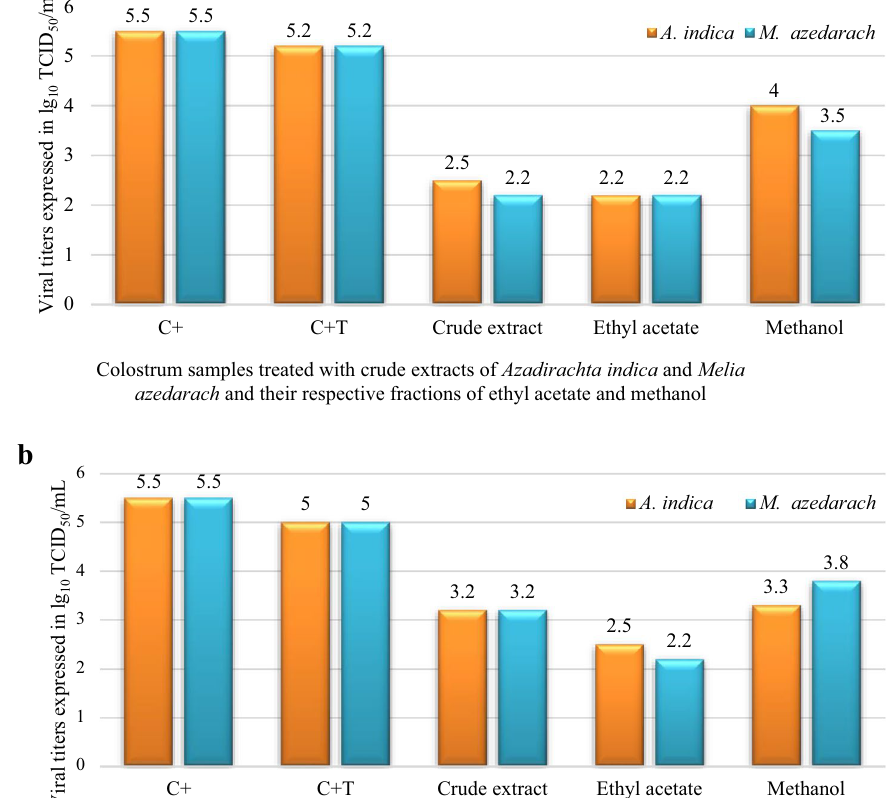
Figure 5. Viral titers of milk and colostrum samples co-cultured with ovine third eyelid (OTE) cells submitted to 90 min treatment composed of ethanolic leaf extracts of Azadirachta indica and Melia azedarach . ( a ) Colostrum samples treated with crude extract of A. indica and M. azedarach leaves and respective ethyl acetate and methanol fractions. ( b ) Milk samples treated with crude extract of A. indica and M. azedarach leaves and respective ethyl acetate and methanol fractions. *TCID50/mL: tissue culture infection dose is the highest dilution that presented, at 14 days post-inoculation, syncytia in 50% of inoculated wells, C+: positive control of standard CAEV CO strain, C + T.: positive control of